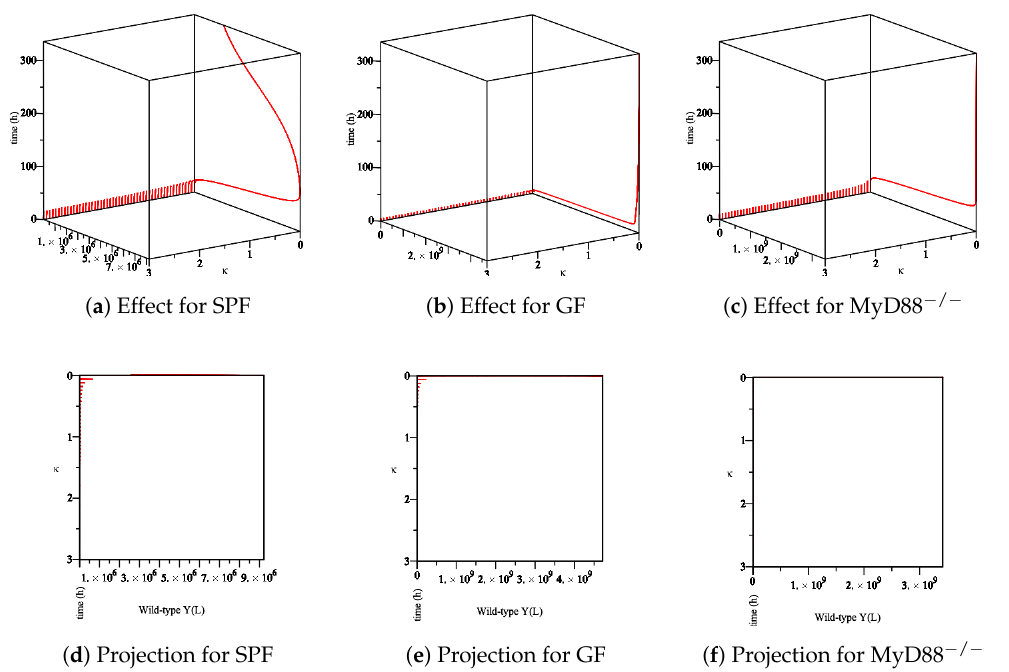
Figure 9. The sensitivity of parameter κ in the elimination of wt Yersinia strain in the lumen. ( a – c ) The effect of the parameter κ on the different types of mice. ( d – f ) The projection of κ for different types of mice.